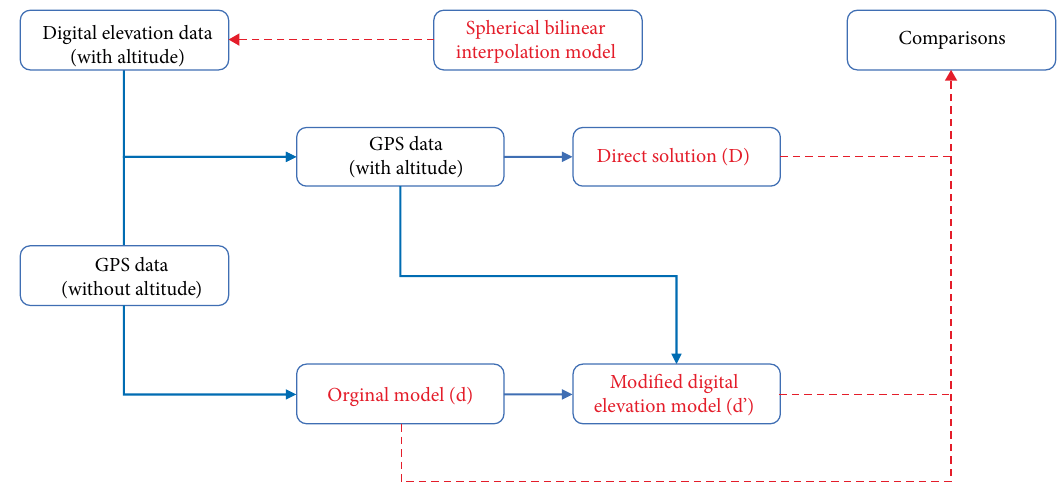
Figure 1: Analysis procedure design. Table 1: Function comparison of direct solution, original model, and MDE